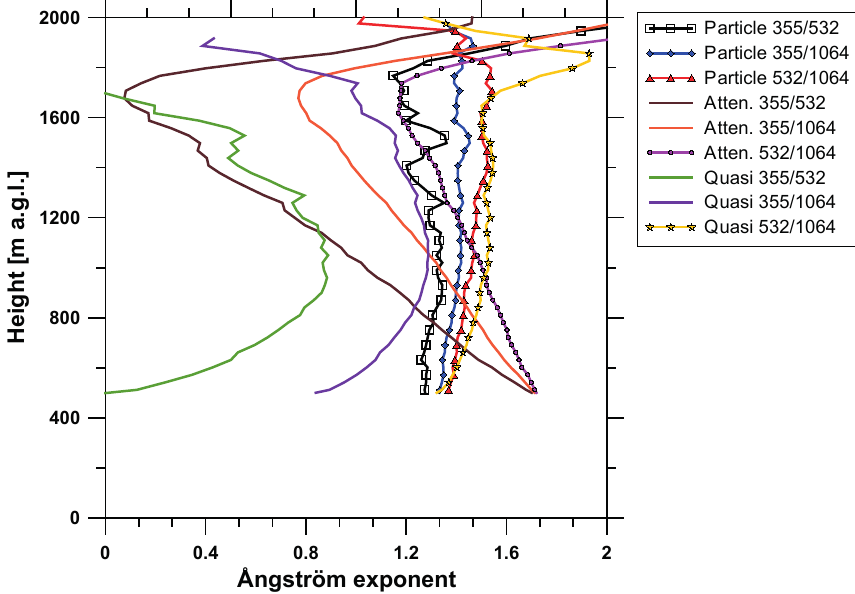
Figure 6. Comparison of Ångström exponents derived from the particle backscatter coefficients determined with the Klett method, the attenuated backscatter coefficients, and the quasi-particle-backscatter coefficients for 22 April 2013, 14:20–14:50UTC. A five-bin vertical smoothing was